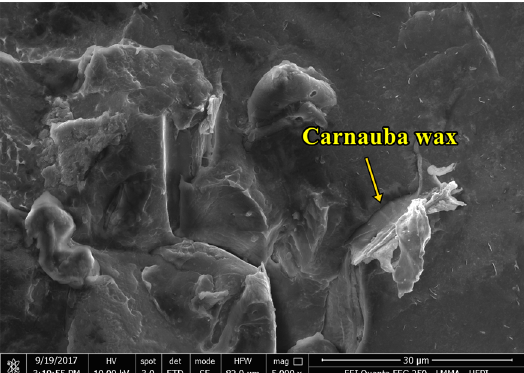
Figure 8. Scanning electron microscopy of the fracture surface of PBAT/SR/CW - 2.5, with a magnification of 5000x. (colored in the online version)